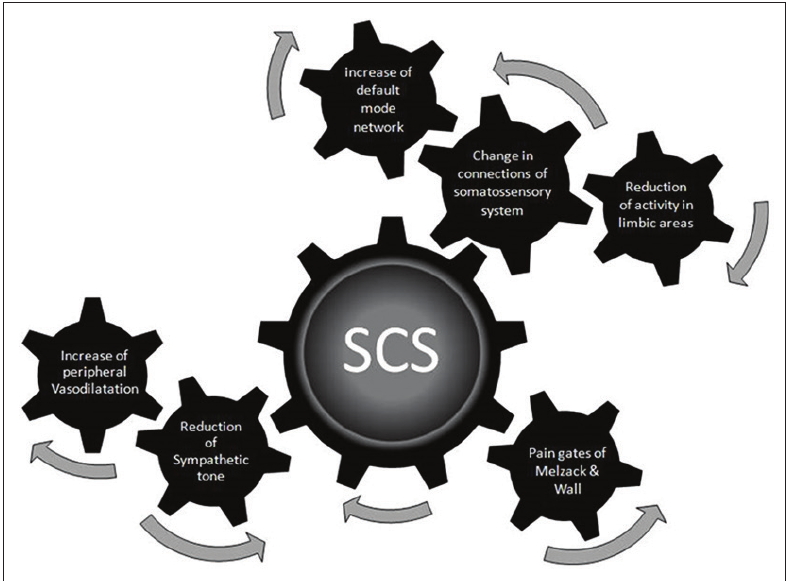
FIGURE 2. Physiological mechanisms of spinal cord stimulation (SCS) include more than just one model or mechanism, illustrating the association between the classical mechanism of pain described by Melzack and Wall (36) and the effect of SCS on blood flow and the somatosensory system